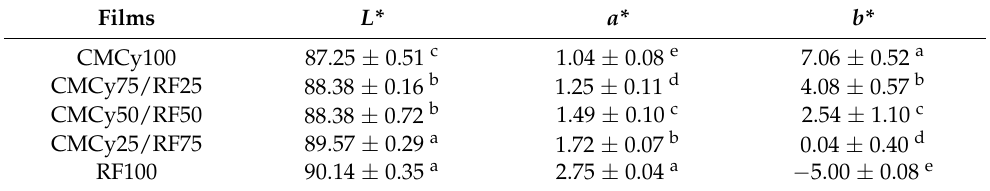
Figure 1. Appearance of ( A ) CMCy film, ( B ) CMCy75/RF25 composite film, ( C ) CMCy50/RF50 composite film, ( D ) CMCy25/RF75 composite film, and ( E ) RF film. Table 3. Color parameters of the CMCy/RF composite biopolymer films produced in different